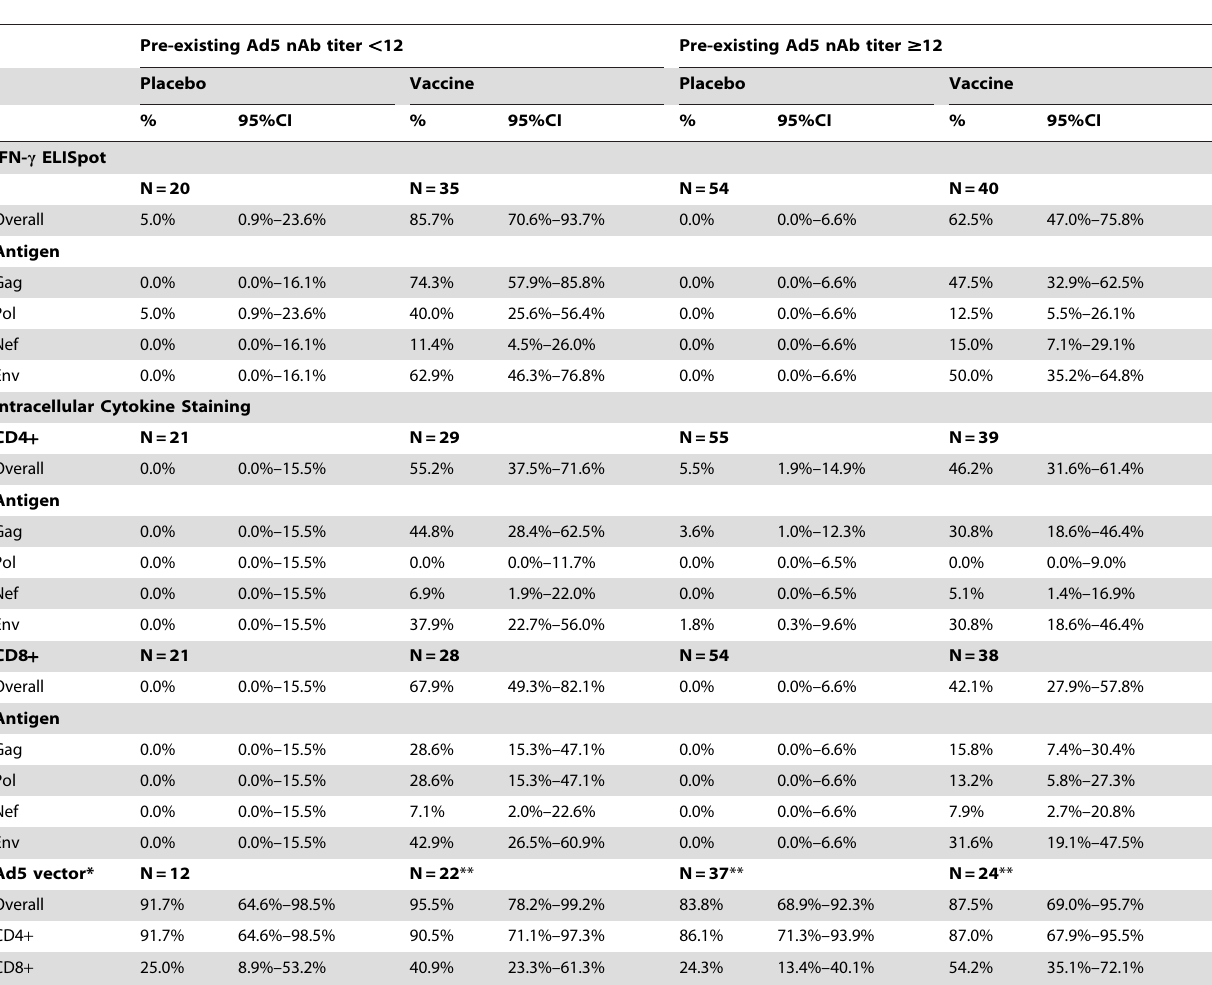
Table 4. Frequency of ELISpot, CD4 and CD8 T-cell ICS responses 6 weeks after Ad5 boost among US participants, stratified by pre- existing Ad5 NAb